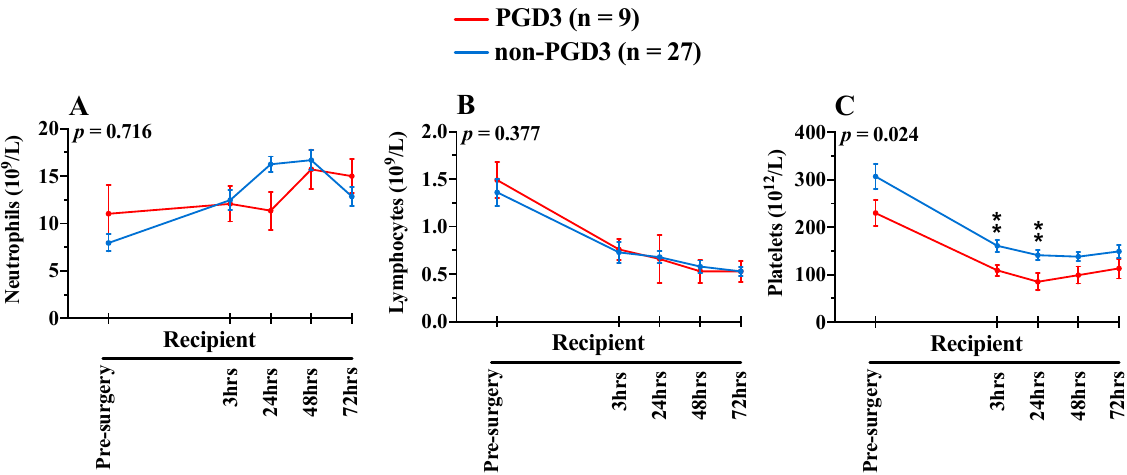
Figure 3. Pre- and postoperative circulating neutrophils ( A ), lymphocytes ( B ) and platelets ( C ) in recipients (n = 36). Blue lines show biomarkers in non-PGD3 recipients (n = 27) and red lines in PGD3 recipients (n = 9) (Mixed-method analyses). The 95% confidence intervals are represented with bars. p values represent the global inter-group comparisons over time. Significant time-point differences are illustrated with asterisks (*). ** p < 0.010.